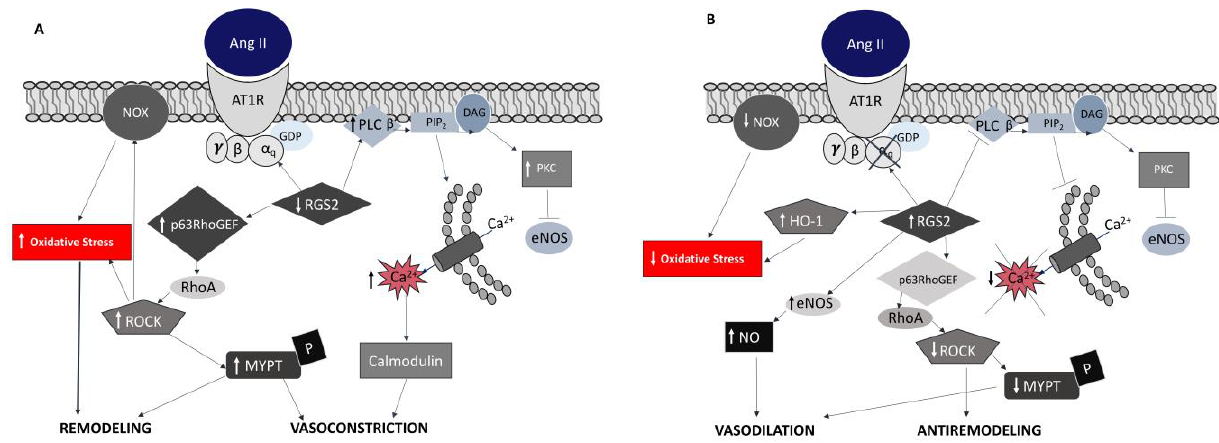
Figure 1. Angiotensin II signaling in chronic kidney disease and hypertension versus angiotensin II signaling in GSBS [3,4,15]. Panel ( A ). Angiotensin II signaling in chronic kidney disease and hypertension promotes through oxidative stress vasoconstriction, vascular remodeling and insulin resistance. Ang II, angiotensin II; AT1R, angiotensin II receptor 1; PLC β , phospholipase C β ; PIP2, phosphatidylinositol diphosphate; DAG, diacylglycerol; PKC, protein kinase C; eNOS, endothelial nitric oxidase; NOX, NAD(P)H oxidase, ROCK, Rho Kinase; MYPT, myosin phosphatase protein target. Panel ( B ). Angiotensin II signaling in GSBS is blunted at post-receptor level, thereby promoting vasodilation and insulin sensitivity through RGS-2 activity. RGS, regulators of G-protein signaling; HO-1, heme-oxygenase 1; NO, nitric oxide.